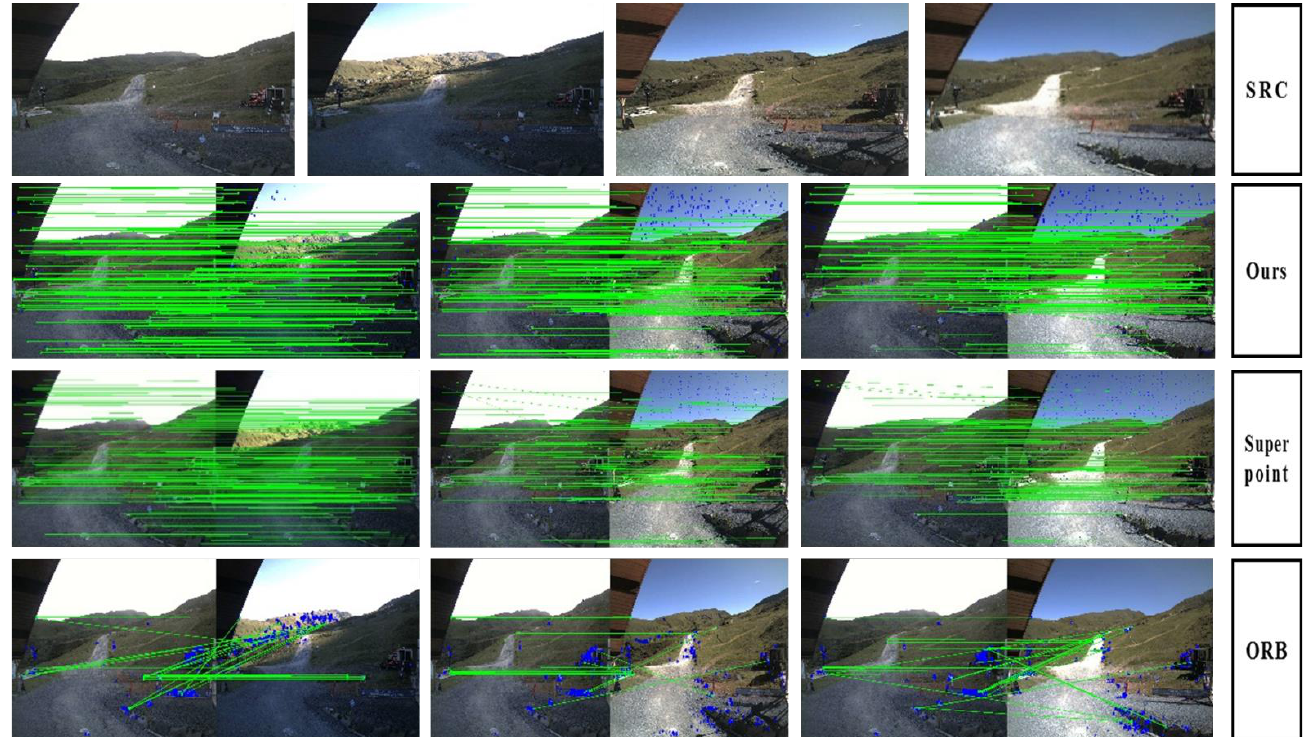
Figure 7. Feature point matching and comparison on illumination.